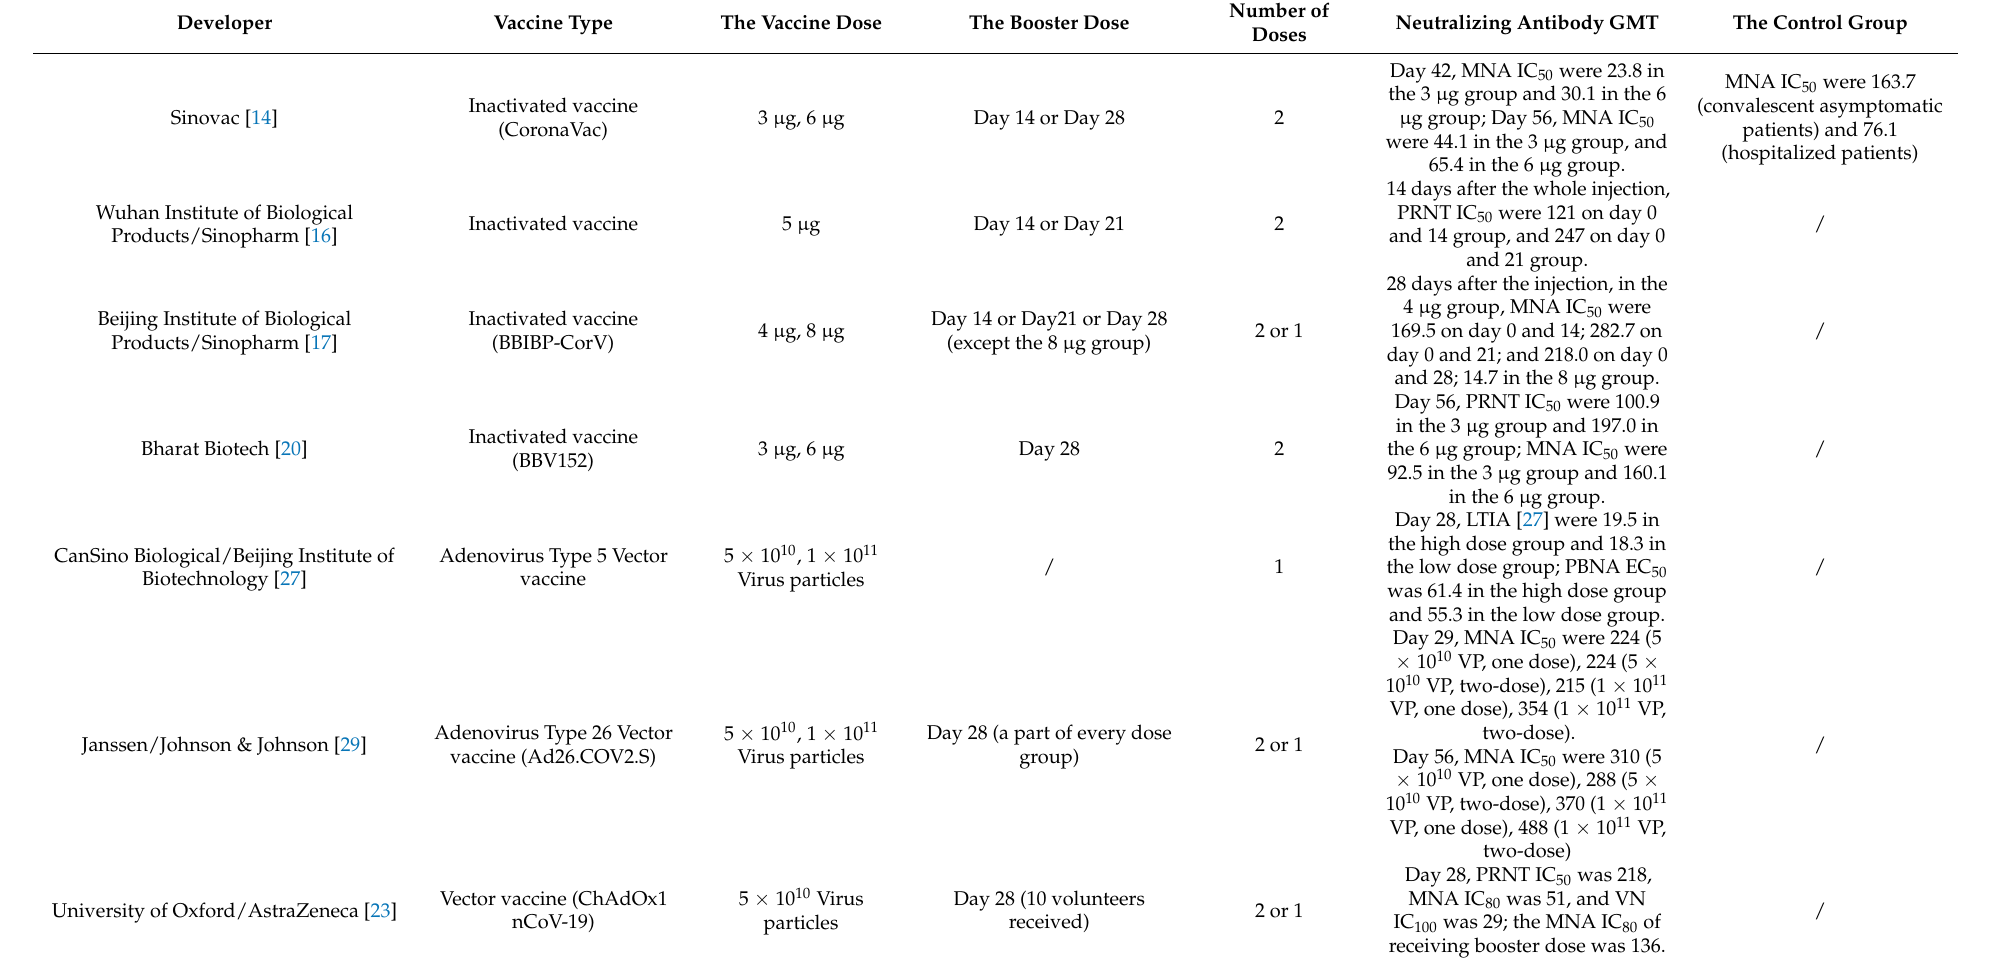
Table 1. Clinical trial results of SARS-CoV-2 candidate